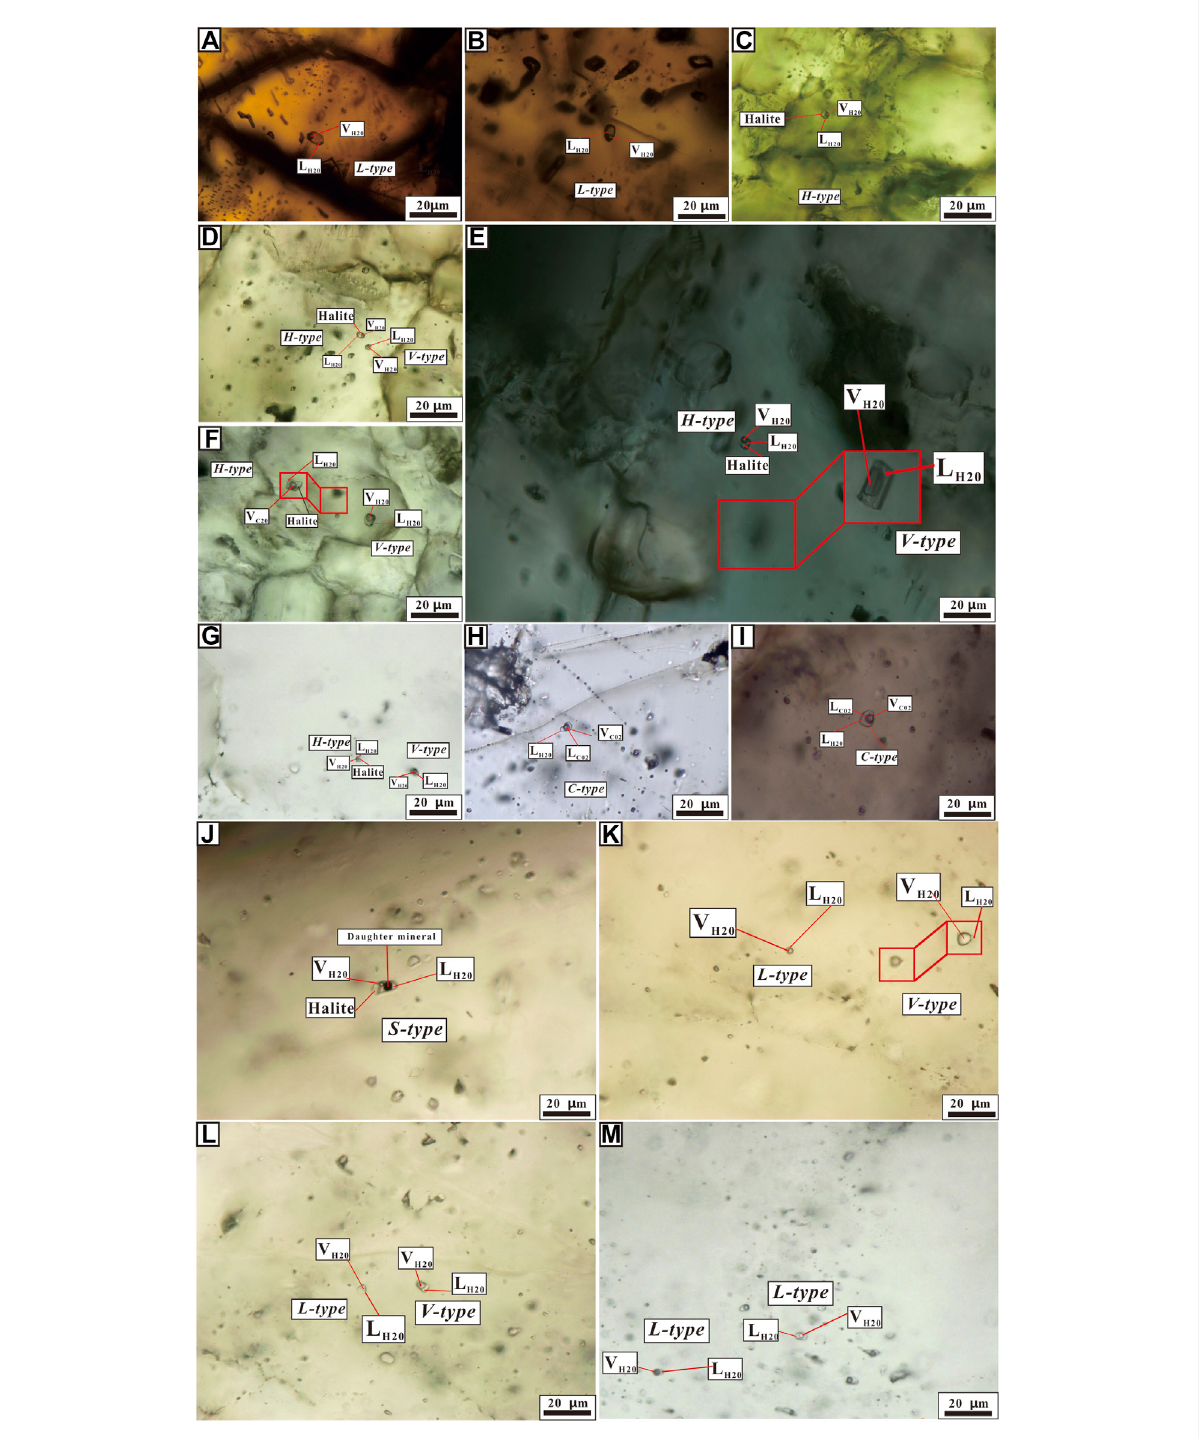
FIGURE 7 Photomicrographs ofrepresentative fl uidinclusions ( fl uidin fl usions)of differenttypes in theShibaogou W(Mo)deposit. (A) Liquid-rich (L-type) fl uid inclusions in garnet; (B) liquid-rich (L-type) fl uid inclusions in garnet; (C) halite-bearing/hypersaline (H-type) fl uid in fl usions in pyroxene; (D) halite-bearing/hypersaline (H-type) fl uid in fl usions in pyroxene; (E) coexisting vapor-rich (V-type) inclusion and halite-bearing/hypersaline (H-type) inclusioninpyroxene; (F) coexistingV-type fl uidinclusionsandL-type fl uidinclusionshostingaquartzcrystalinstageIpyroxene; (G) coexisting vapor-rich (V-type) inclusion and halite-bearing hypersaline (H-type) inclusion in pyroxen; (H) CO 2 -bearing three phase inclusions (C-type) in stage II quart; (I) CO 2 -bearing three phase inclusions (C-type) in stage II quart; (J) S-type inclusion in stage II quart; (K) L-type and V-type fl uid in fl usions in stage III quartz; (L) L-type fl uid in fl usions in stage IV calcite; and (M) L-type fl uid in fl usions in stage IV